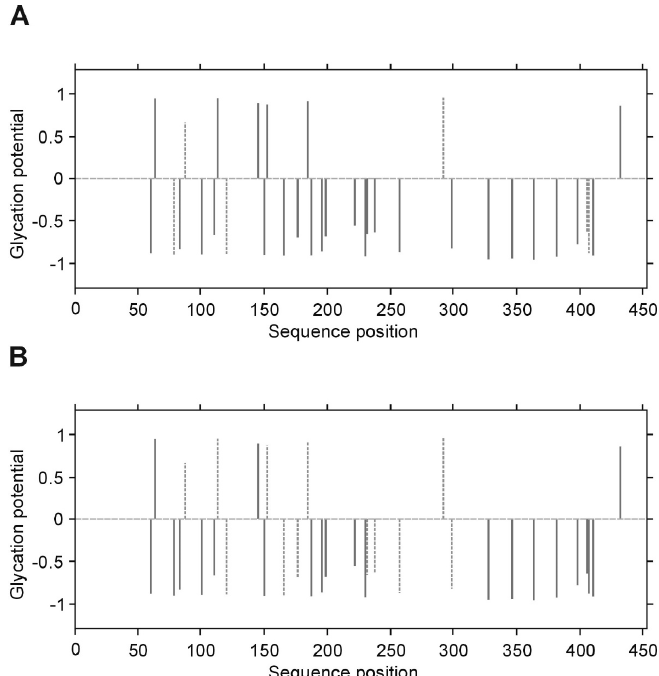
Figure 9. Predicted glycation sites in the γ chain of human fibrinogen, evaluated by NetGlycate v1.0 software. Each plot presents the scores of glycation potential (bars), given for all 34 Lys residues of the γ chain in control volunteers ( A ) and diabetic patients ( B ), which are relevant to the numbers between − 1 and 1 (threshold marked as grey dashed line); a score above 0 means that the residue is a predicted glycation site, while a score below 0 means that the residue is unlikely to be glycated. The bars marked by dashed thick lines denote the residues that were found to be really glycated in the examined subjects.